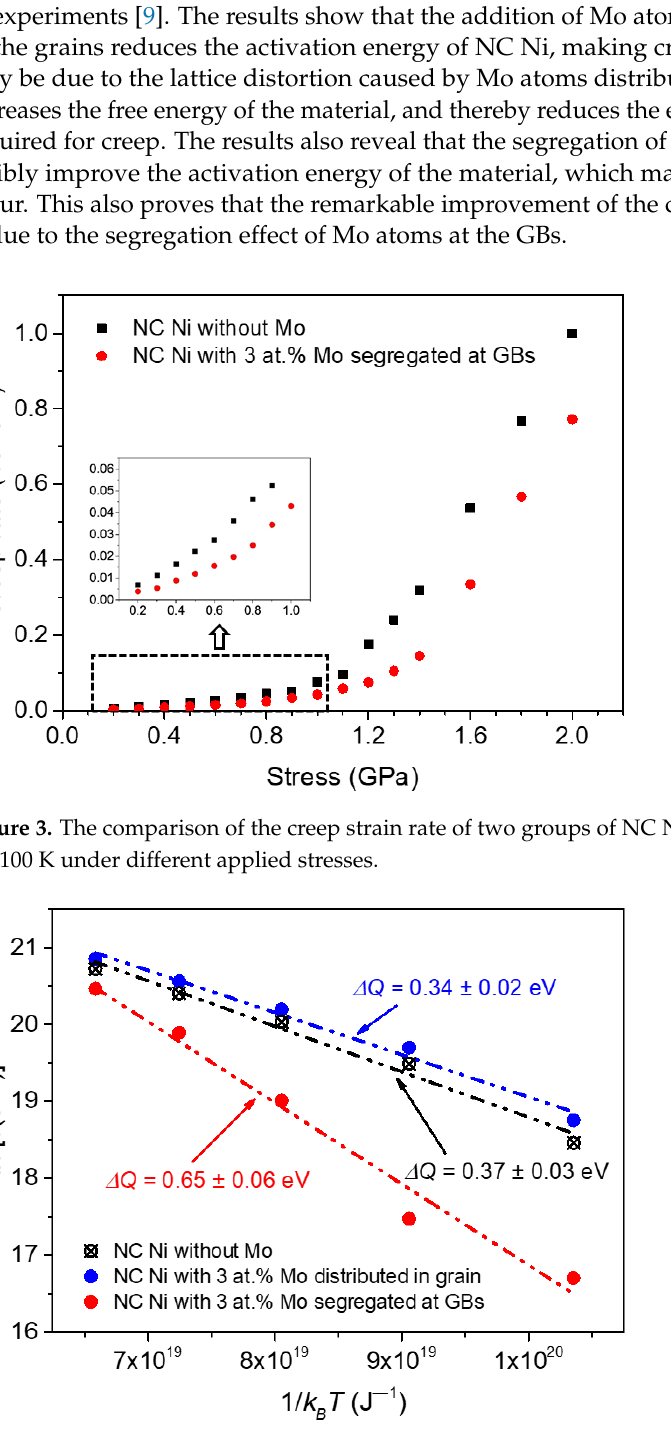
Figure 4. Arrhenius plot of the creep rate against the reciprocal temperature of NC Ni with 𝑑 = 10.9 nm under an applied stress of 2 GPa.